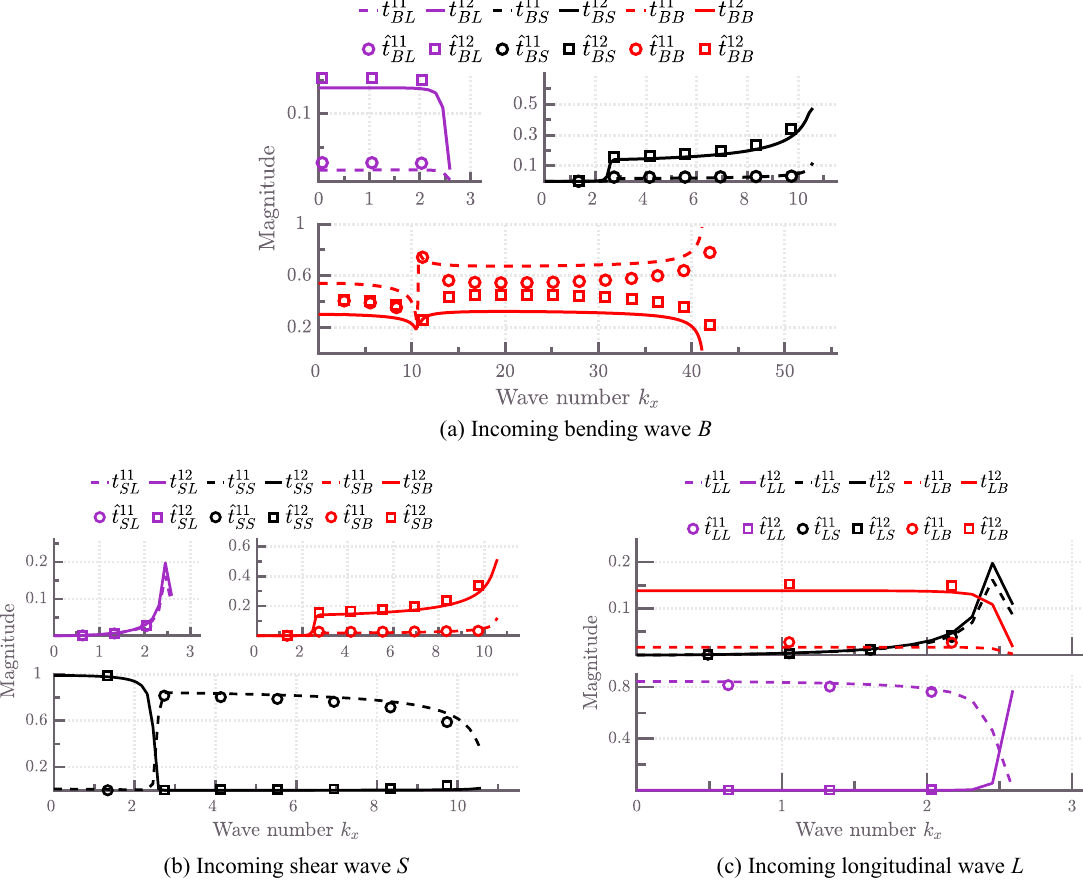
Figure 7. Energy scattering coefficients of an L-junction of two SOLID185-based cross-ply laminated plates for various incident waves plotted with respect to the wave number component k x at a frequency f = 3000 Hz. ˆ t nm ij denote semi-analytical scattering coefficients obtained using the method presented in 20